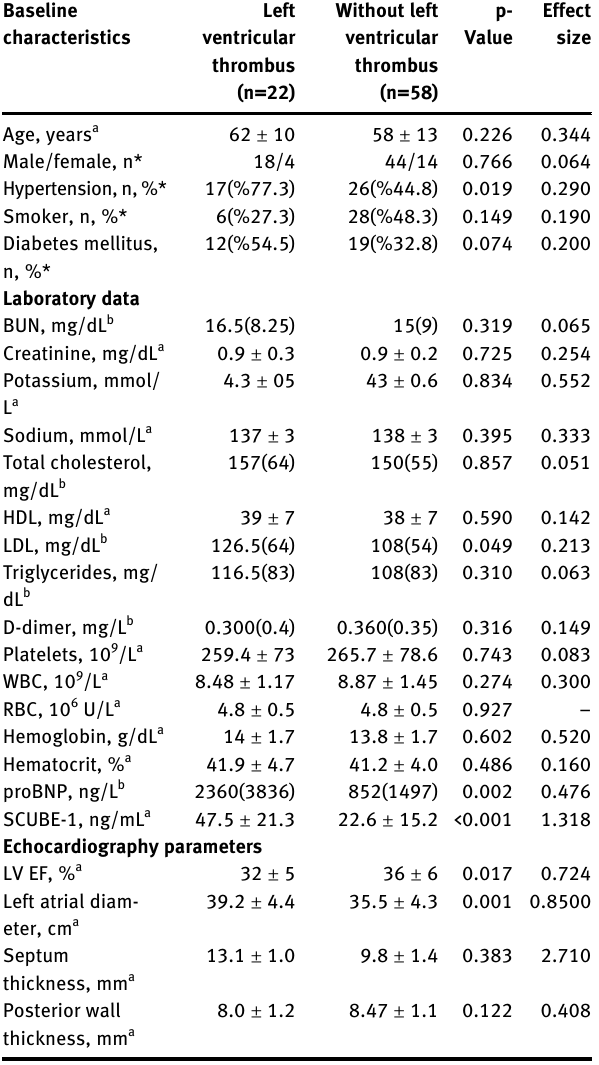
Table  : Baseline characteristics of study patients. Baseline